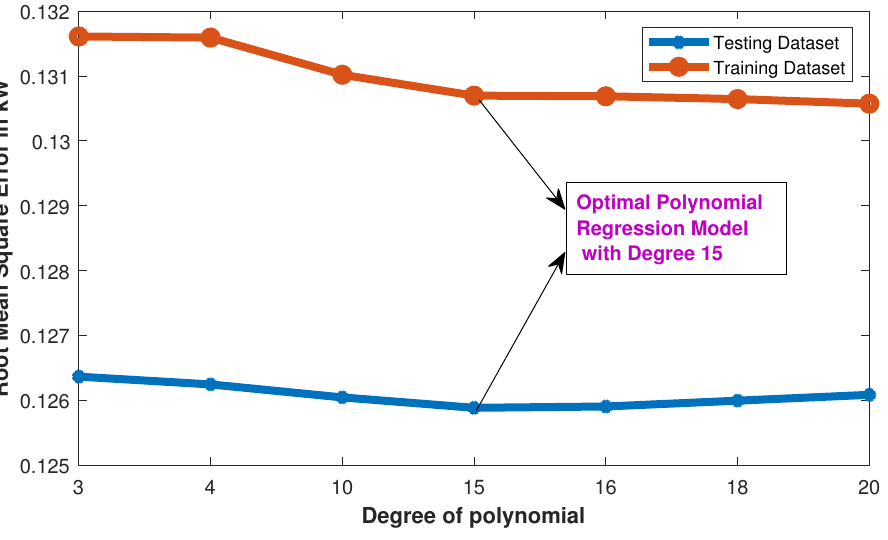
Figure 19. PR: identification of Optimal PR Model.